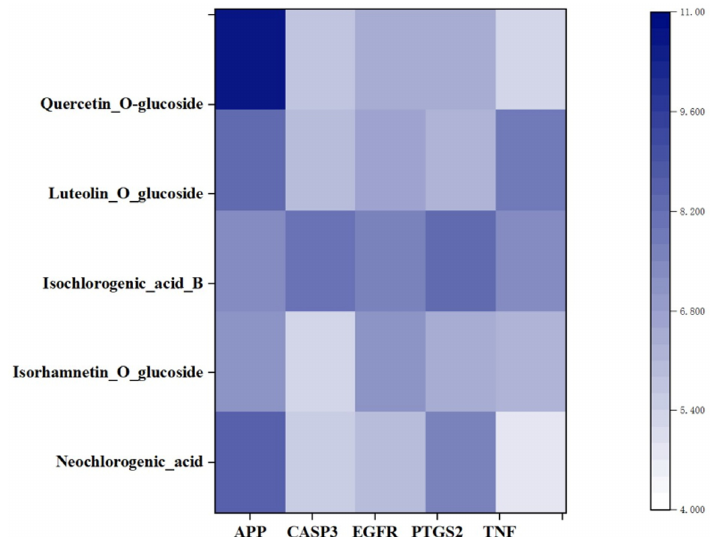
Figure 5. Heatmaps shows Surflex-Dock score (total score) of top 5 hub genes combining to 5 key bioactive compounds in LJF.